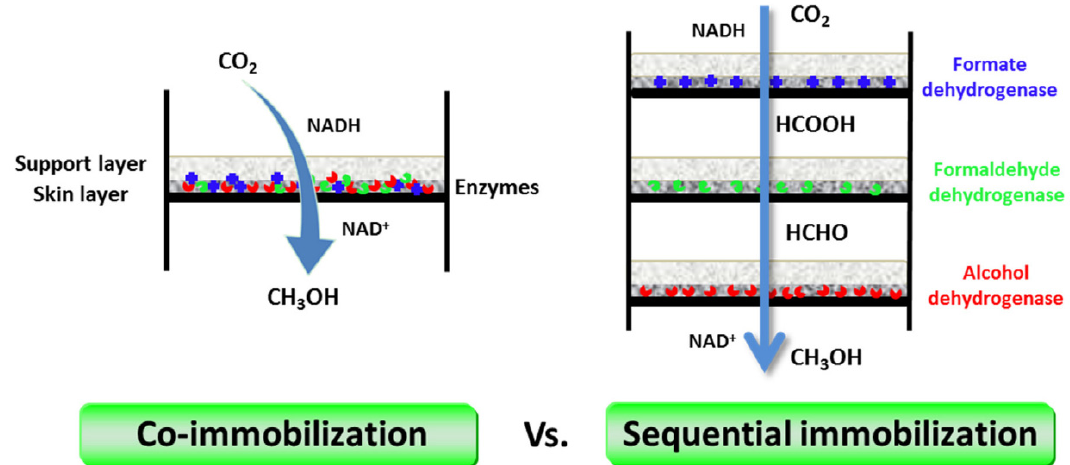
Figure 5. Enzyme membrane reactor setup for the production of methanol from CO2: co-immobilization versus sequential immobilization of enzymes in membranes [17].